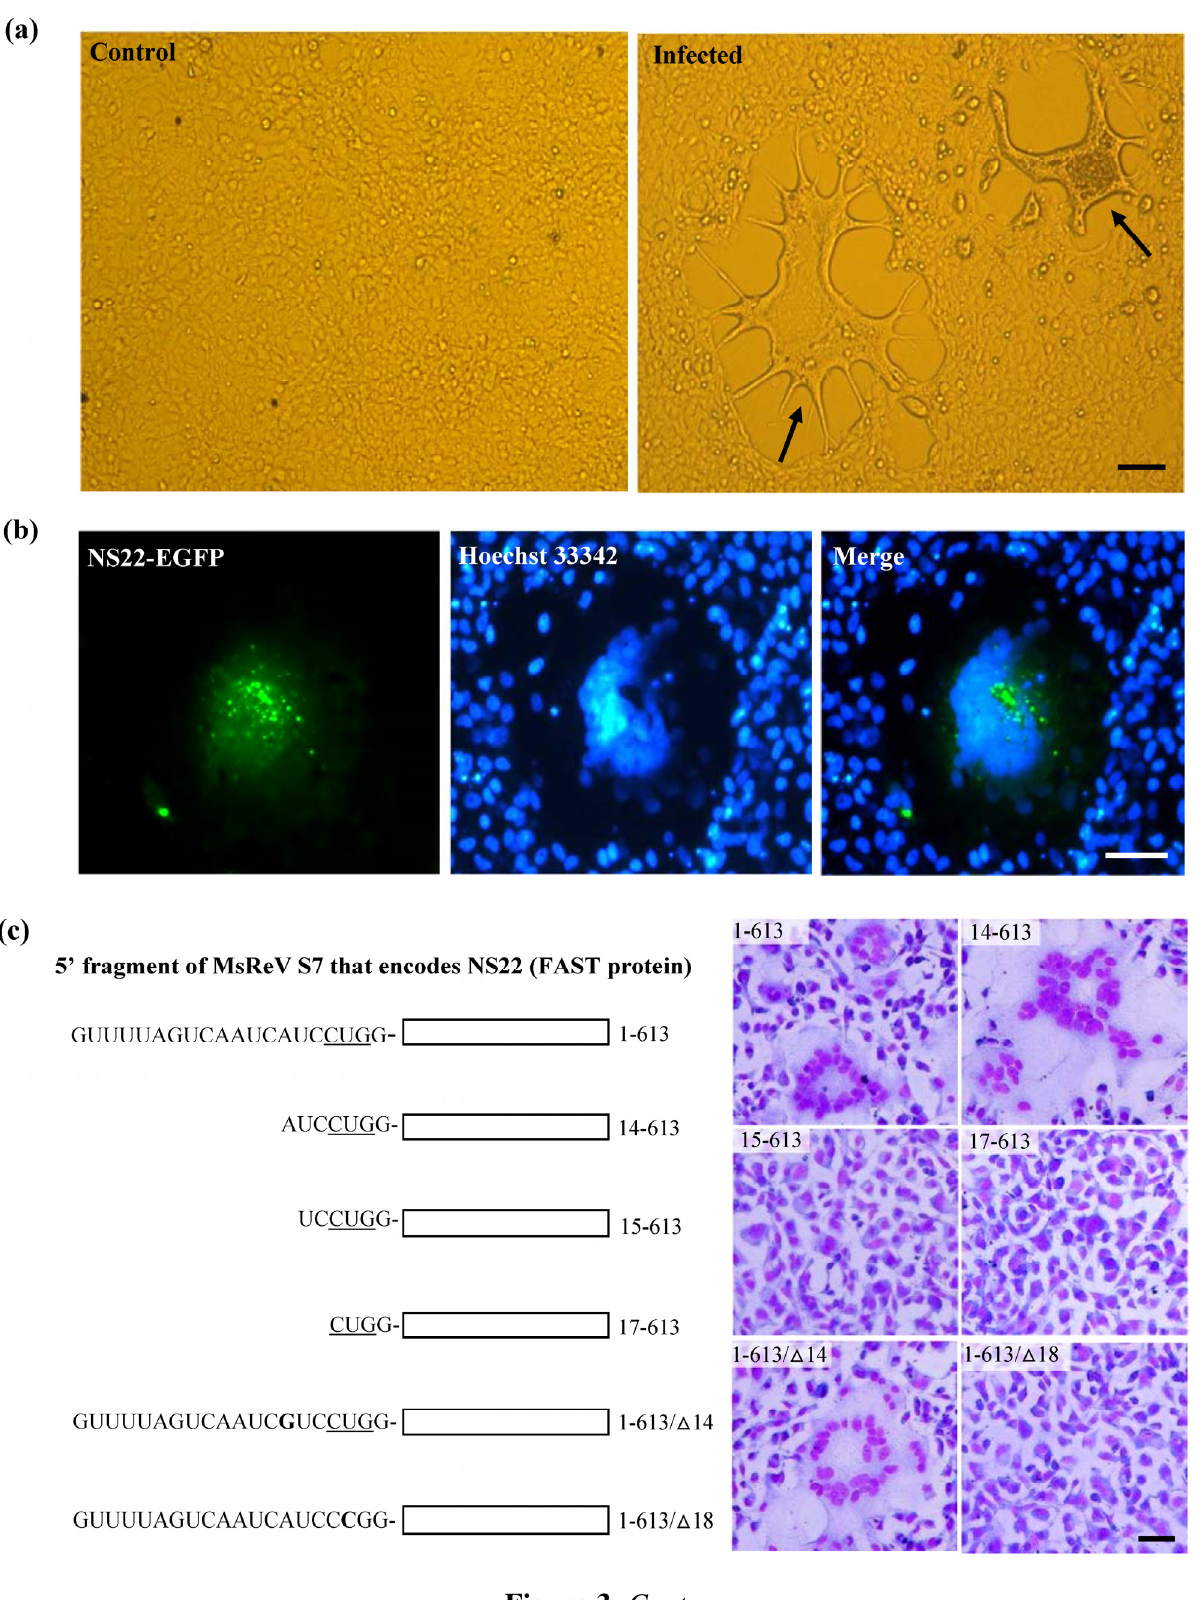
Figure 3. Cont. Figure 3.